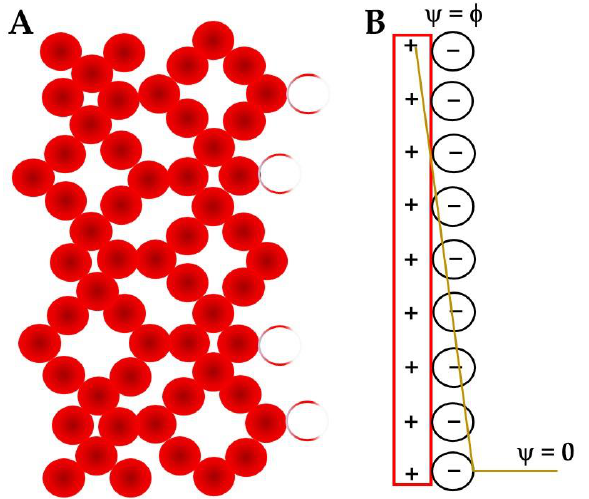
Figure 1. ( A ) An example surface showing how the bulk atoms are bonding with the neighboring ones, while the surface atoms have missing bonds, represented by the empty circles. ( B ). Helmholtz’s electric double layer model shows the electrode surface (red rectangle), positively charged, while the electrolyte responds to this potential by generating an anion monolayer (black circumferences). The potential drop as a function of the distance from the electrode is shown as a golden line.